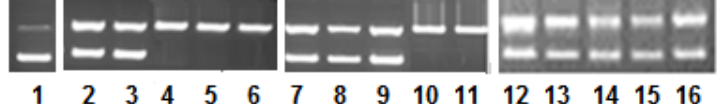
Figure 5. Concentration dependent pattern of pBR322 DNA (100 ng) by complex 1 (lane 2–6), complex 2 (lane 7–11), and complex 3 (lane 12–16) (0.5–2.5 µ M), in 50 mM Tris-HCl/NaCl buffer pH 7.4